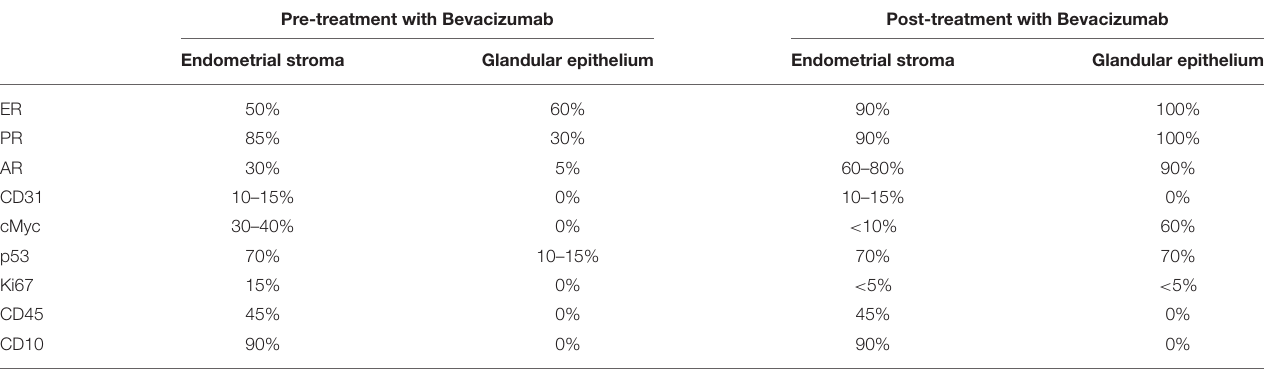
TABLE 1 | Immunohistochemical characterization of endometriosis lesions. Pre-treatment with